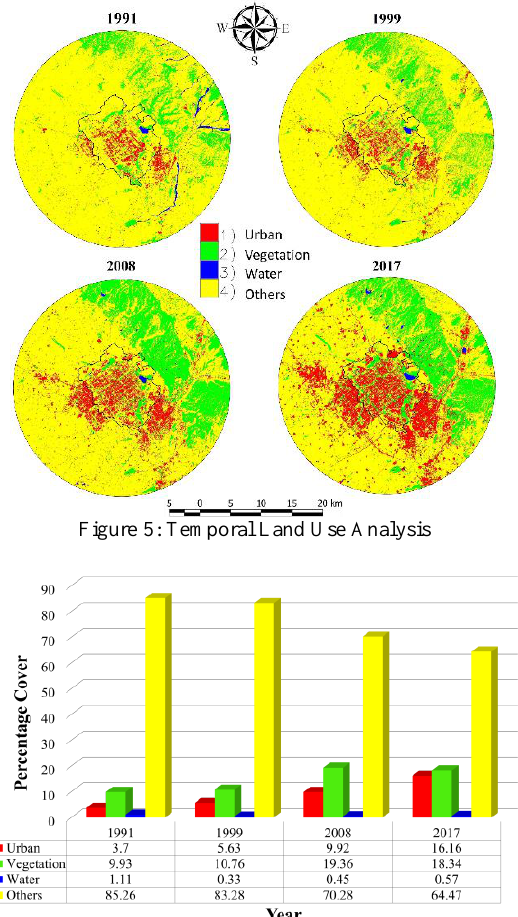
Figure 6: Percentage cover by each land use class during the study